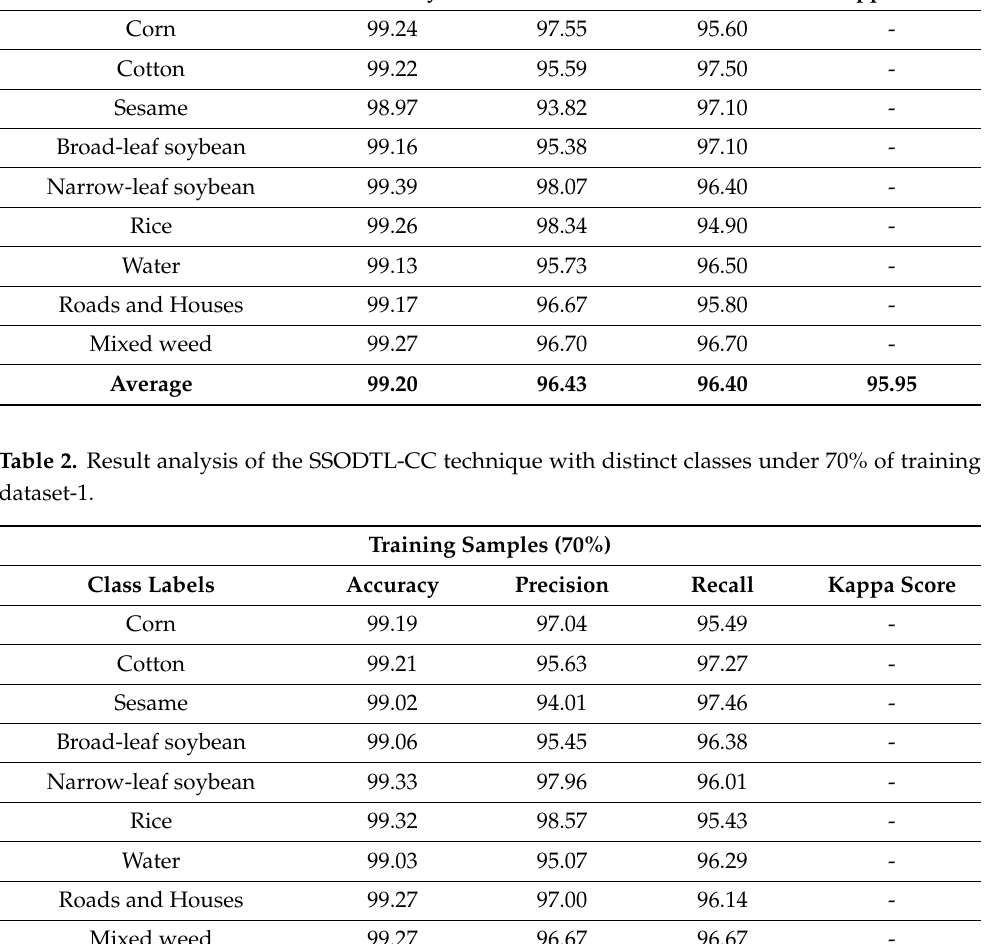
Table 3 defines the detailed crop classification outcomes of the SSODTL-CC model